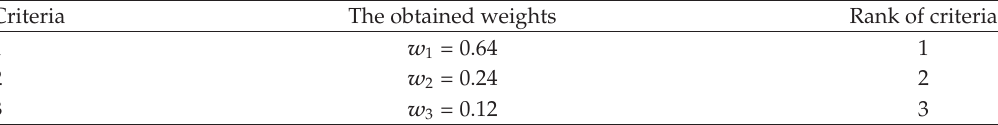
Table 2: The result of proposed method for Example 2 (cid:2) see Section 4.2 (cid:3) .